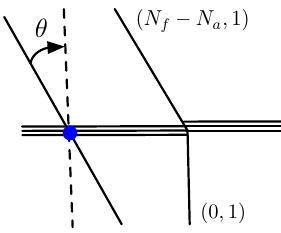
Figure 5 . When N f < N a , there is always an intersection between NS5’-brane and NS5-brane.